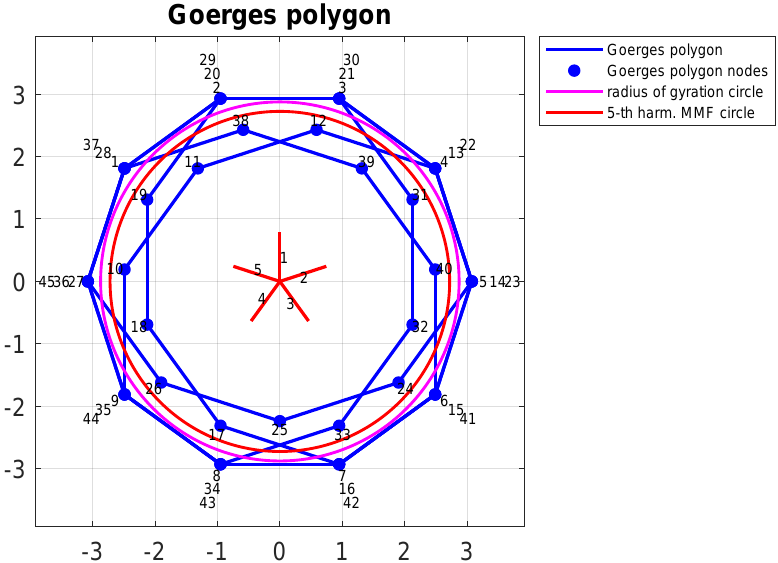
Figure 4. Mapping of the N − p configurations with D . U . < 5% and σ 0 < 20% ( m = 3 ÷ 6).